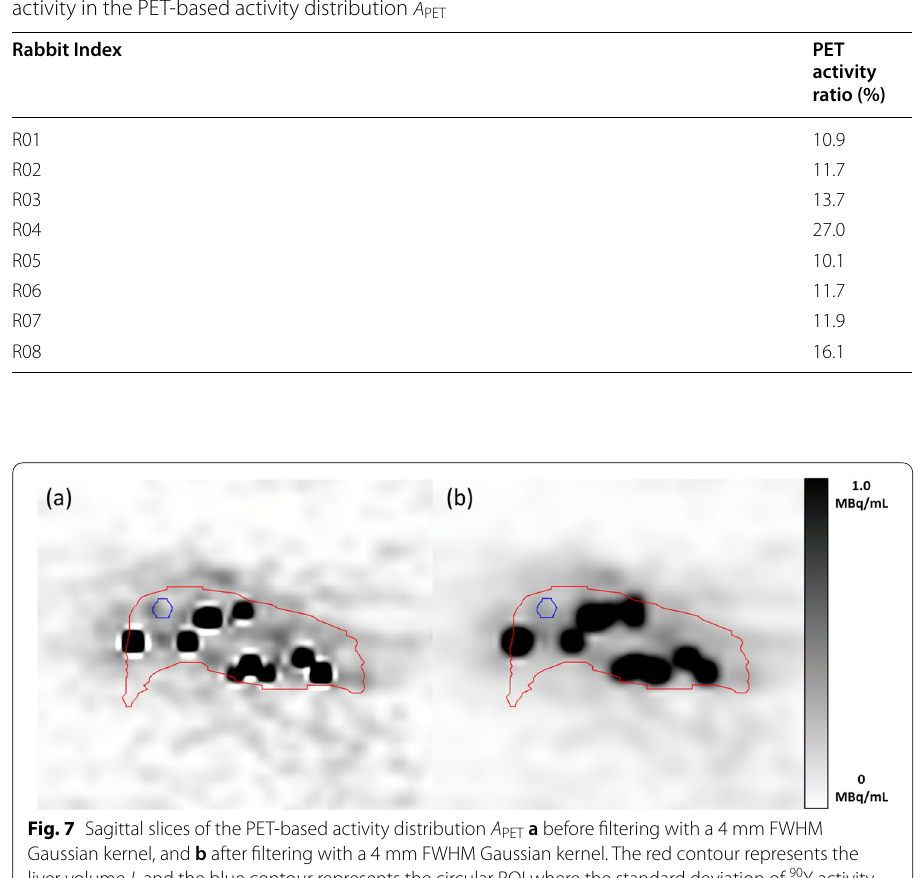
10 5 Bq/mL. After filtering, the standard deviation was ×